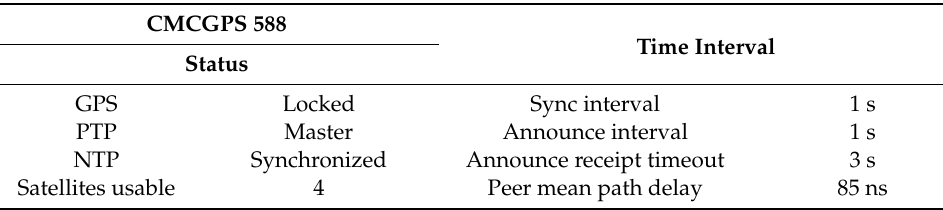
Table 2. PTP time synchronization and settings.